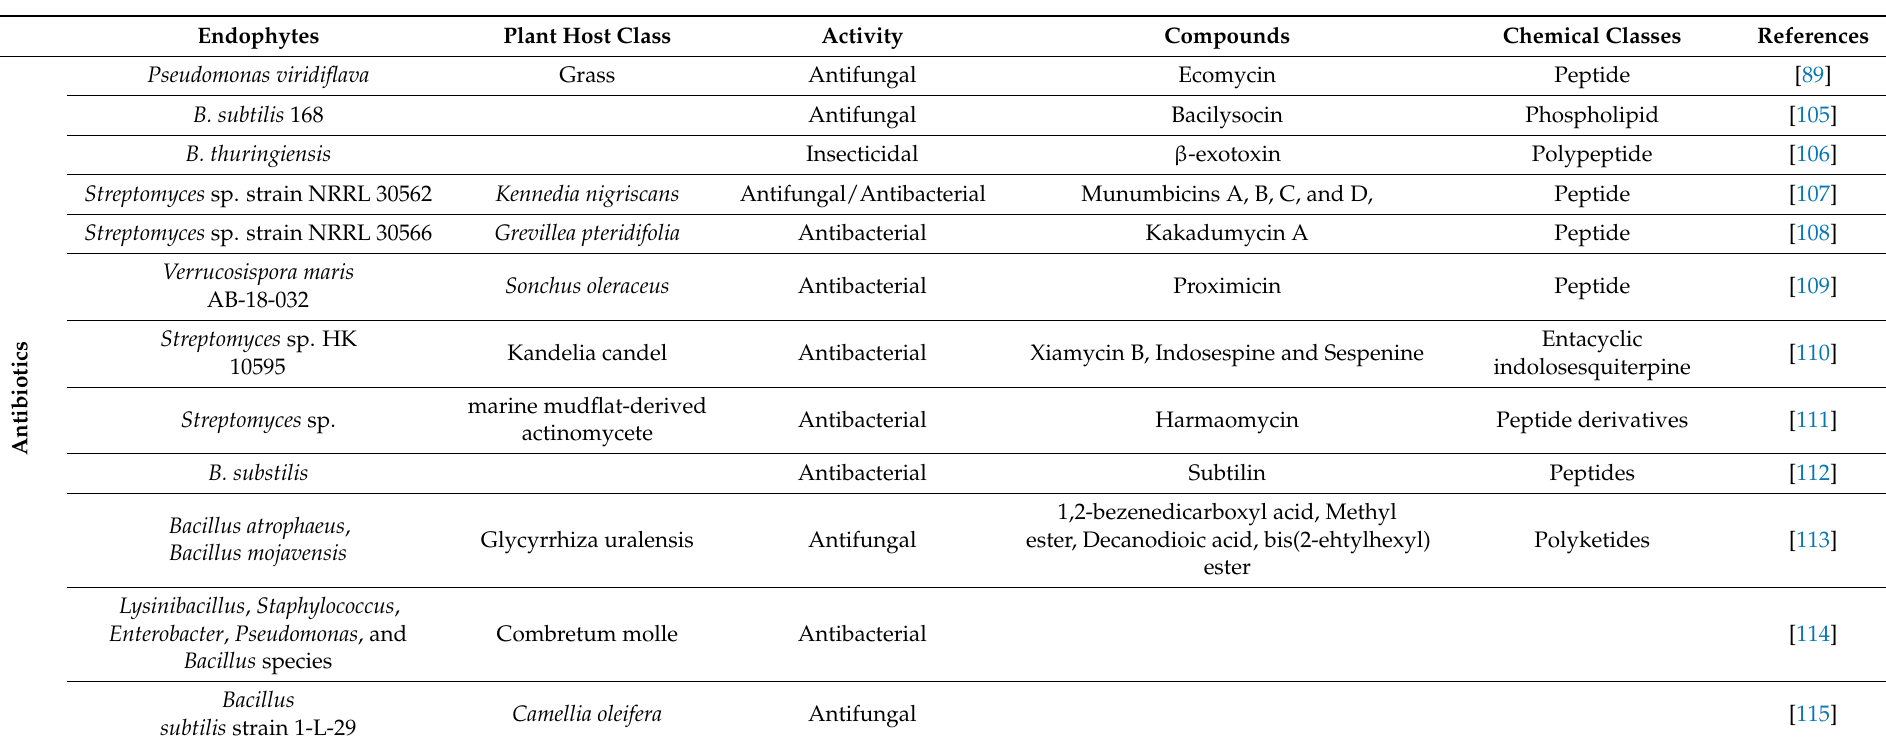
Table 1. Antimicrobial compounds produced by the bacterial